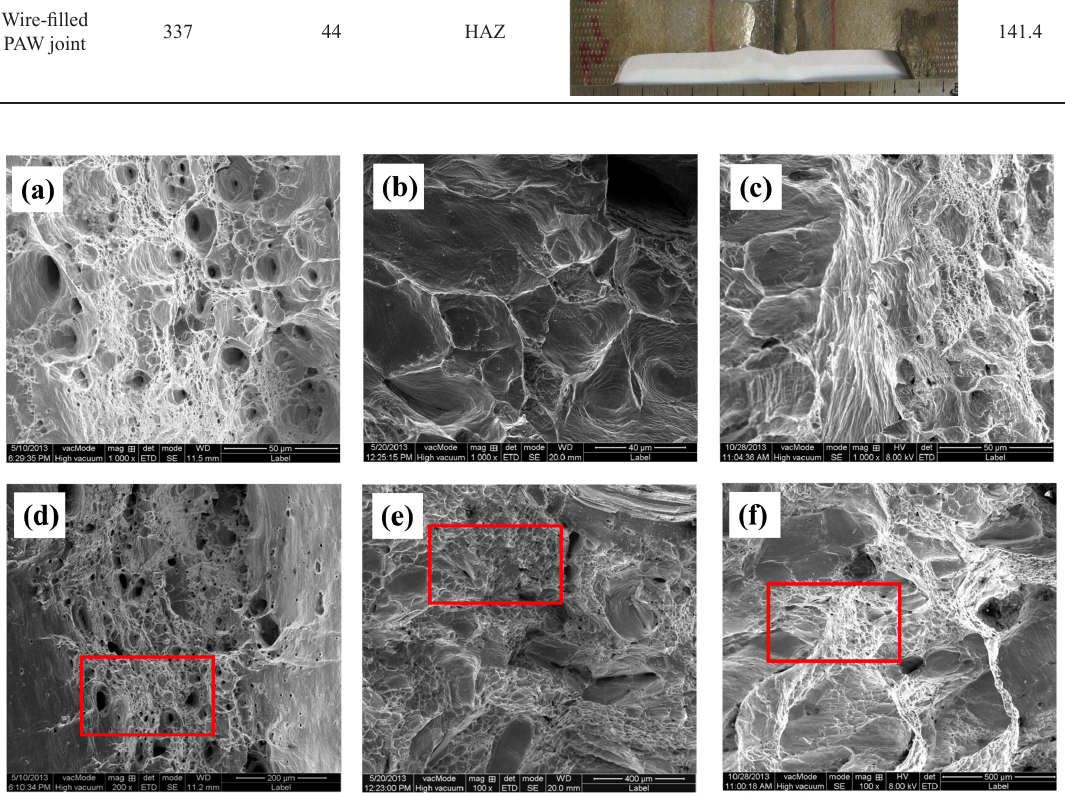
Figure 8. Tensile fracture of base metal and welded joints(a)base metal(b)PAW joint(c)wire-filled PAW joint (a), (b), (c) high-magnification photograph, (d), (e) e (f) SEM photograph of macro